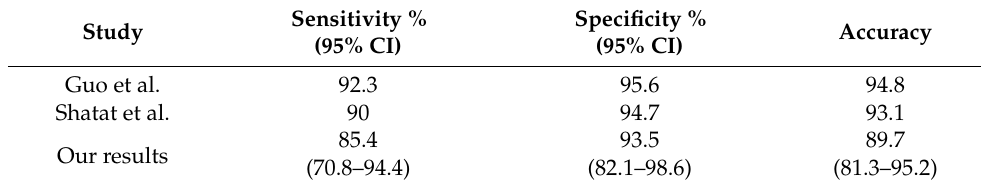
Table 4. Diagnostic performance of fused images in evaluating myometrial